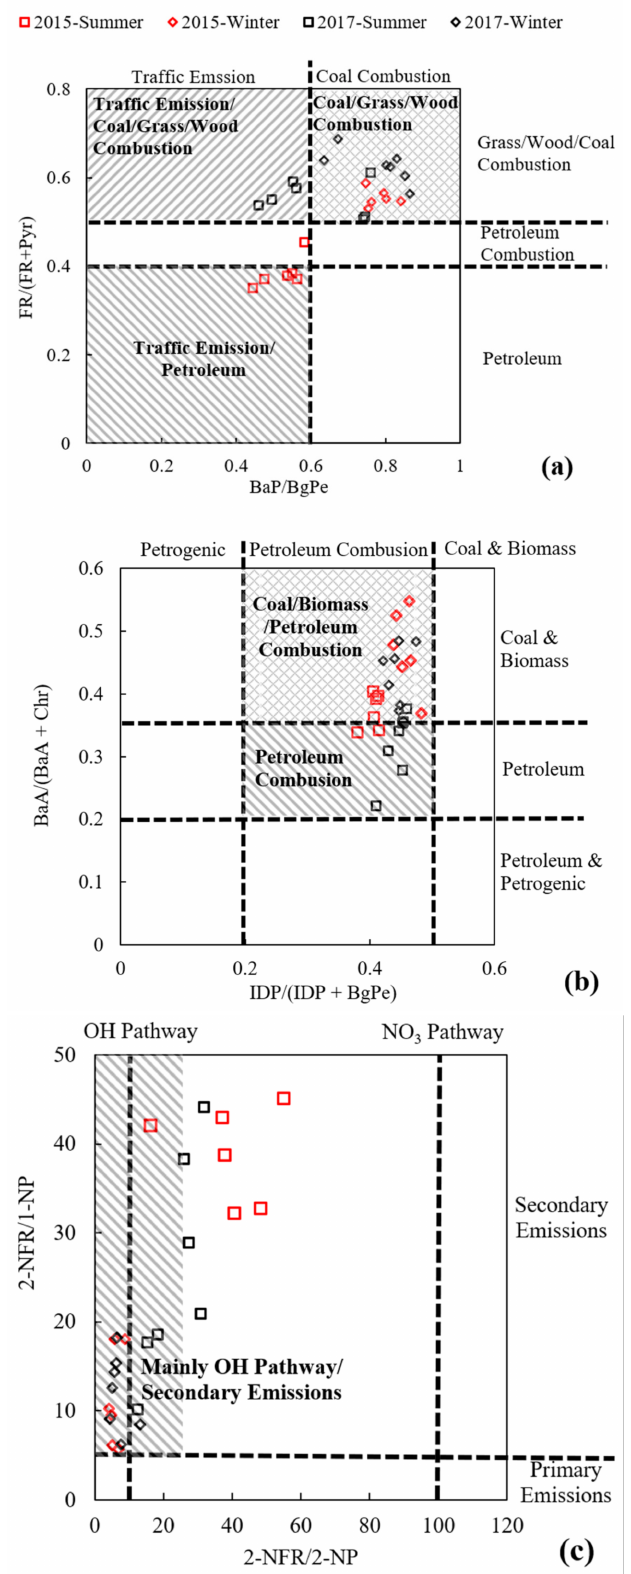
Figure 3. The diagnostic ratios on the sources of PAHs and NPAHs emissions ( a ) BaP/BgPe vs. FR/(FR+Pyr) [45,46] ( b ) IDP/(IDP+BgPe) vs. BaA/(BaA + Chr) [47] ( c ) 2-NFR/2-NP vs. 2-NFR/ 1-NP